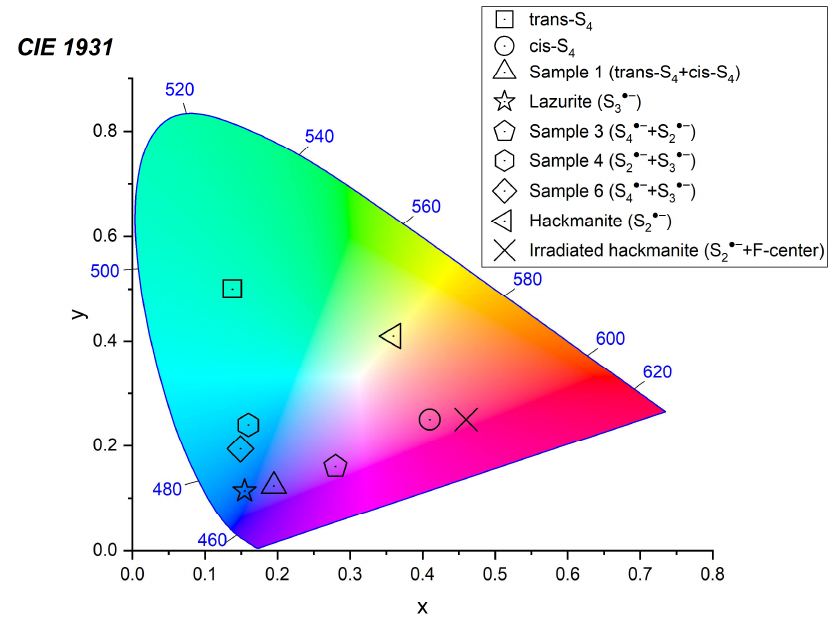
Figure 22. Color space chromaticity diagram for sodalite-group minerals.